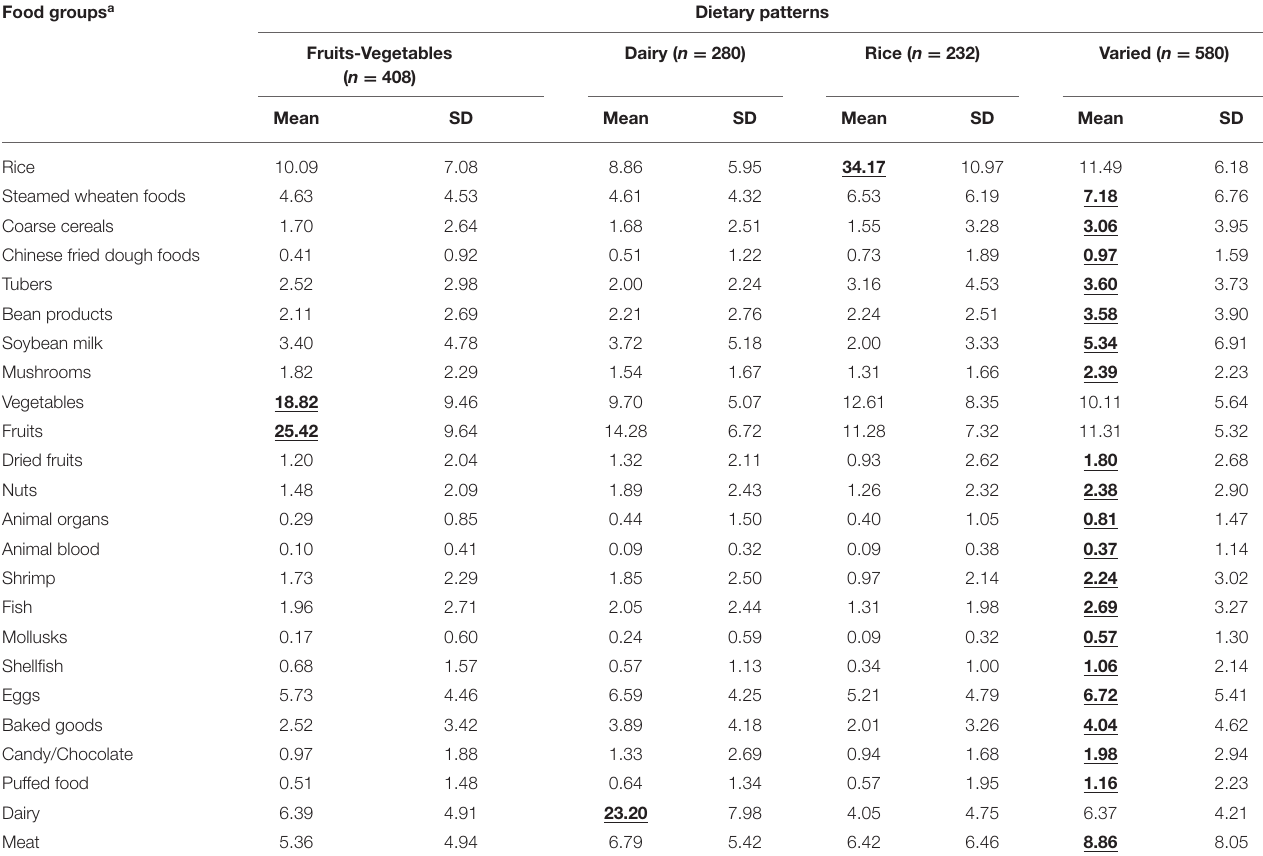
TABLE 3 | Percentages (%) of weekly intake of 24 food groups assessed with a self-administered food frequency questionnaire across the four dietary patterns identified among 1,500 women in this prospective cohort. Food groups